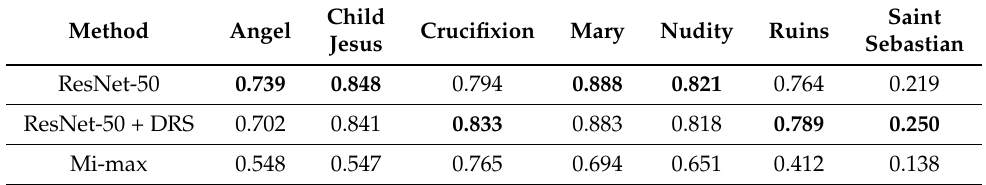
Saint Sebastian